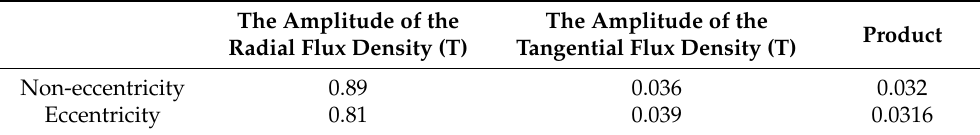
Table 1. The fundamental component amplitude of the radial and tangential magnetic density in both cases. The Amplitude of the The Amplitude of the Product Radial Flux Density (T) Tangential Flux Density (T) Non-eccentricity 0.89 0.036 0.032 Eccentricity 0.81 0.039